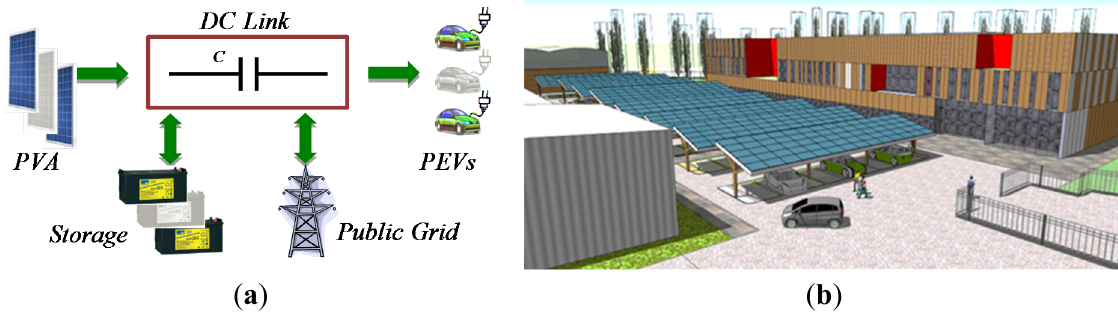
Figure 1. ( a ) DC microgrid for an electric vehicle charging station; ( b ) Computer graphic